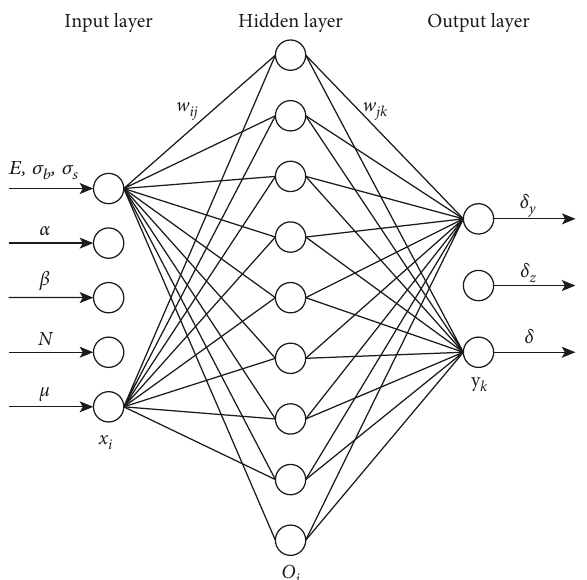
Figure 6: Frame chart of the BP neural